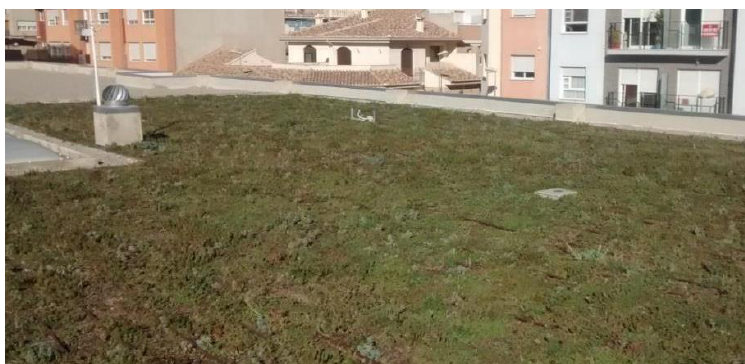
Figure 7. Monitoring system scheme. A set of six type T thermocouples, whose positions and missions are detailed in Table 1, enables to determine the evolution of the temperature at different layers of the roof. These temperature measurements allow identifying similar ambient temperature conditions in the registered data sets and provide the data required for the simulation tools. Specifications of the thermocouple sensors were: Probe PT100 RS PRO M16, PT100, +100 to + 450 °C, diameter 6mm, Connection head, Class B 4 Stainless Steel.